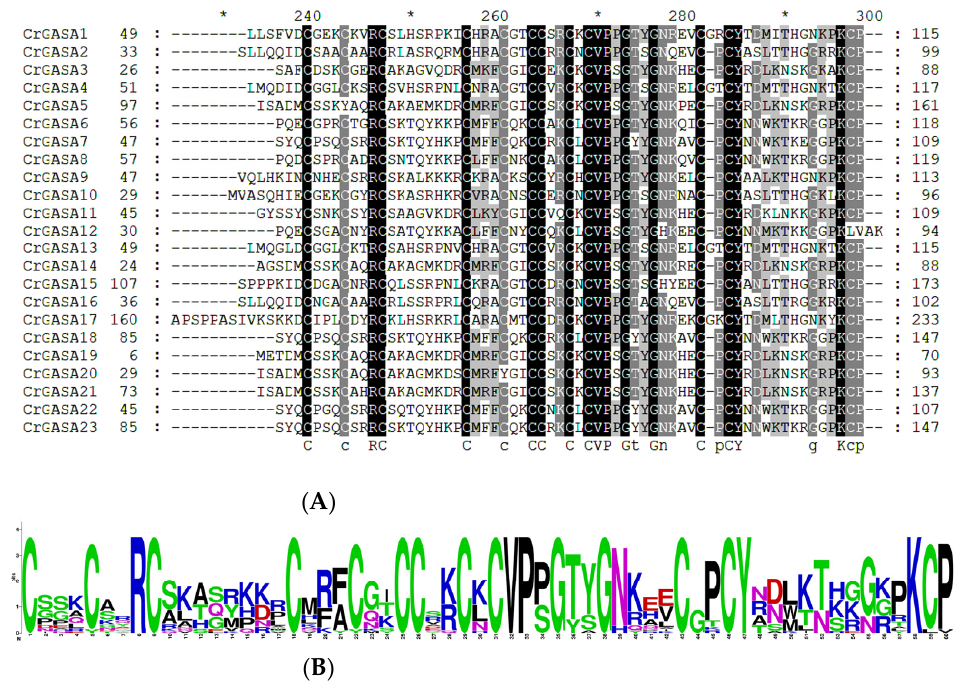
Figure 3. Alignment of the GASA domain from CrGASA proteins. ( A ) Multiple alignments of the CrGASA protein sequences. Their conserved GASA domains are indicated. ( B ) Sequence logo analysis of the conserved GASA domains. Each stack represents their amino acids.